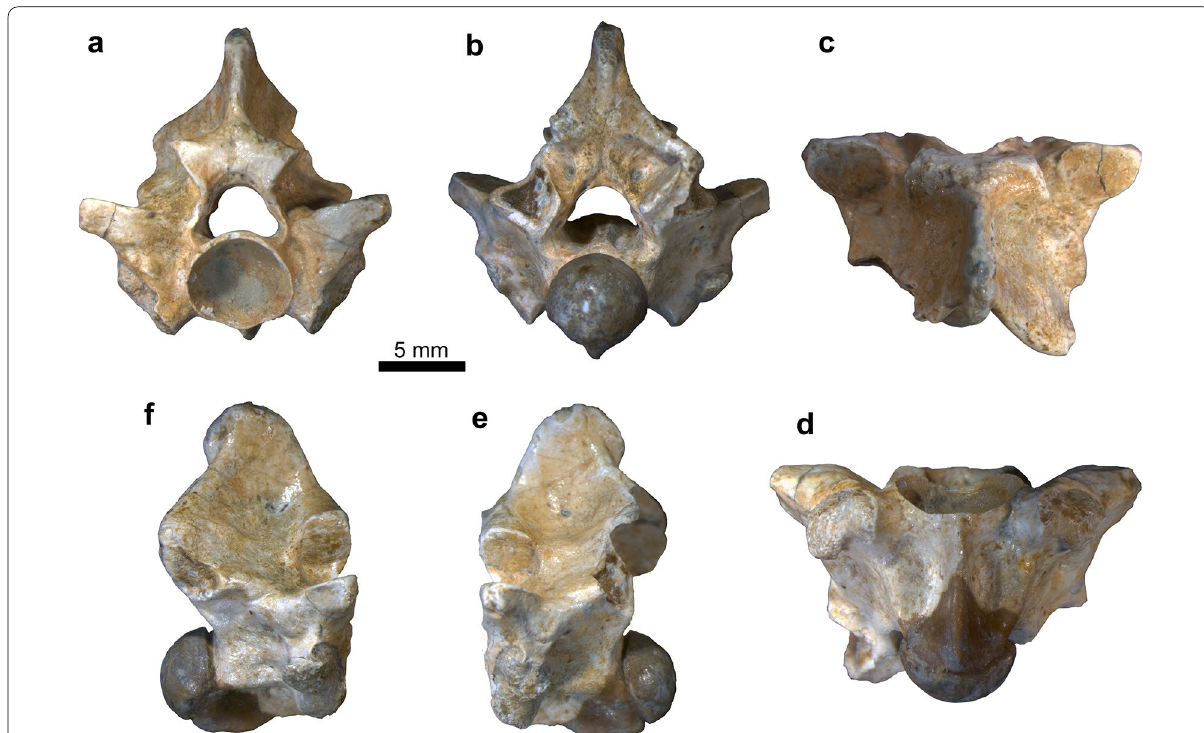
Fig. 32 Palaeopython helveticus from Dielsdorf: holotype trunk vertebra (PIMUZ A/III 634) in anterior ( a ), posterior ( b ), dorsal ( c ), ventral ( d ), left lateral ( e ), and right lateral ( f ) views. Figure reproduced from Georgalis and Scheyer (2019a:fig. 5); copyright by the Swiss Geological